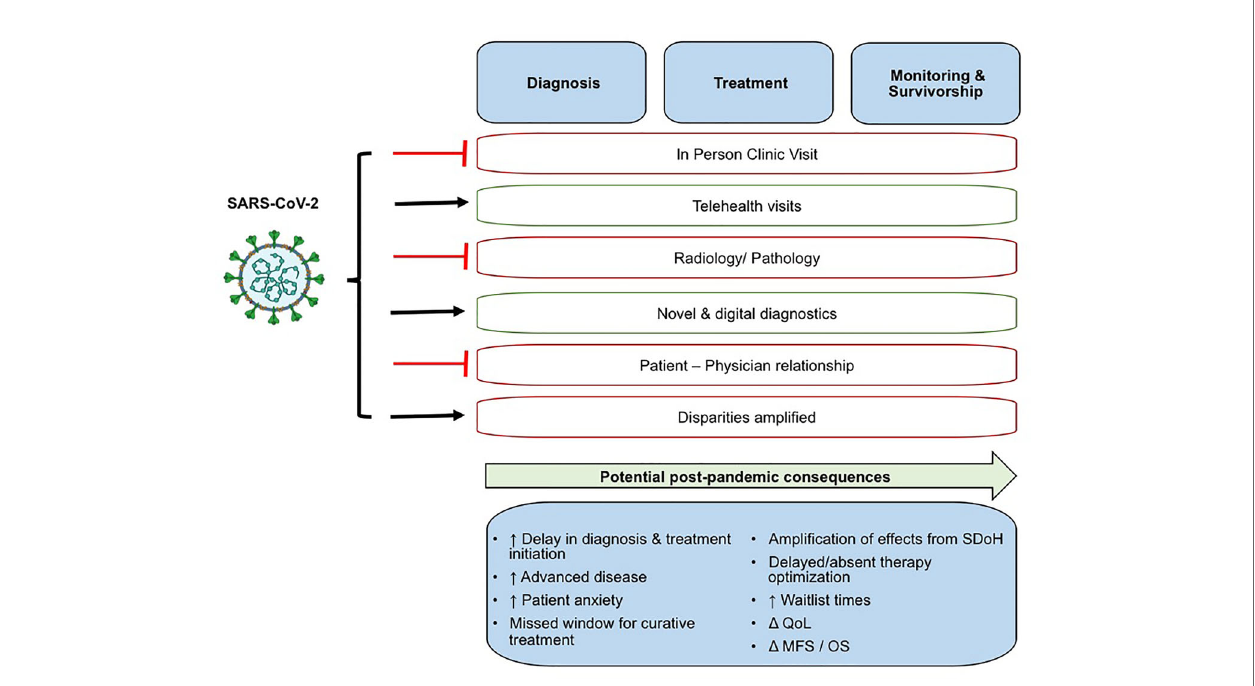
FIGURE 1 | The effects of COVID-19 on the diagnosis, treatment, management, survivorship and disease monitoring in patients with GU cancers. QoL, Quality of Life; MFS, metastasis free survival; OS, overall